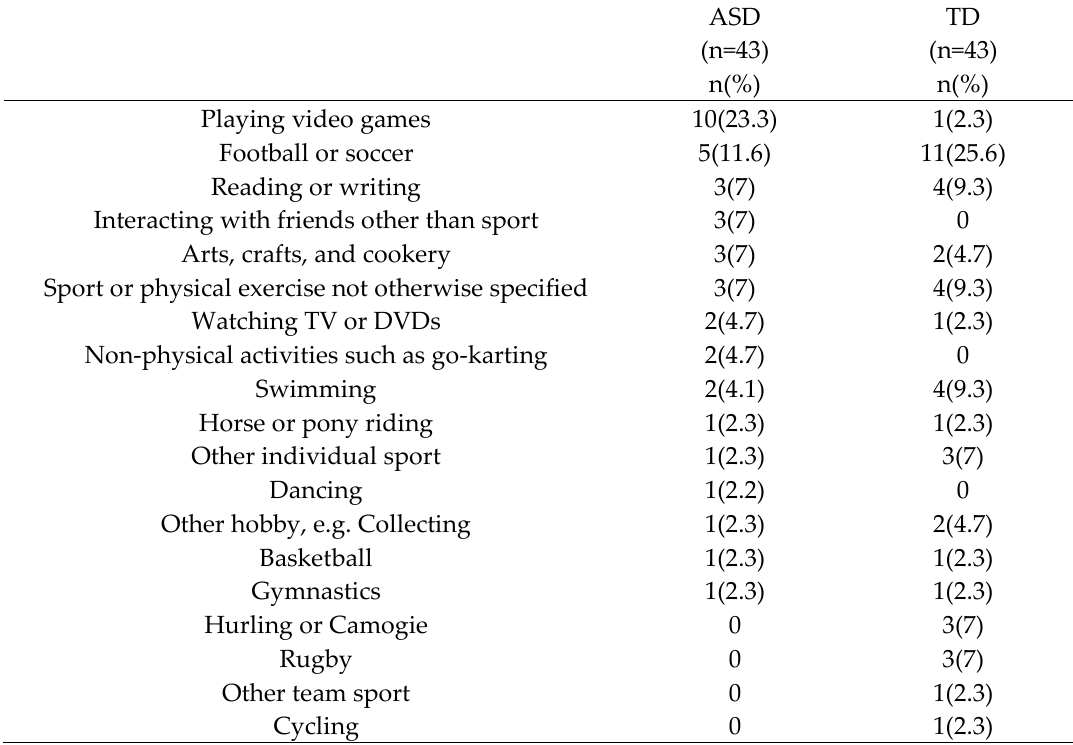
Table 1. Hobby preferences among children with and without